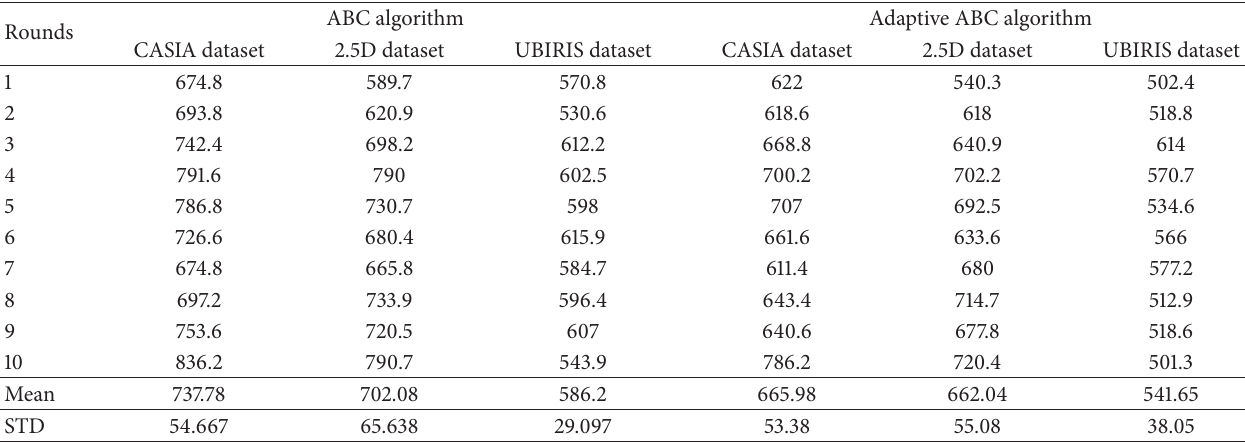
Table 12: Mean time (in seconds) and its standard deviation for the three datasets taken by conventional and adaptive ABC algorithm for the best fitting